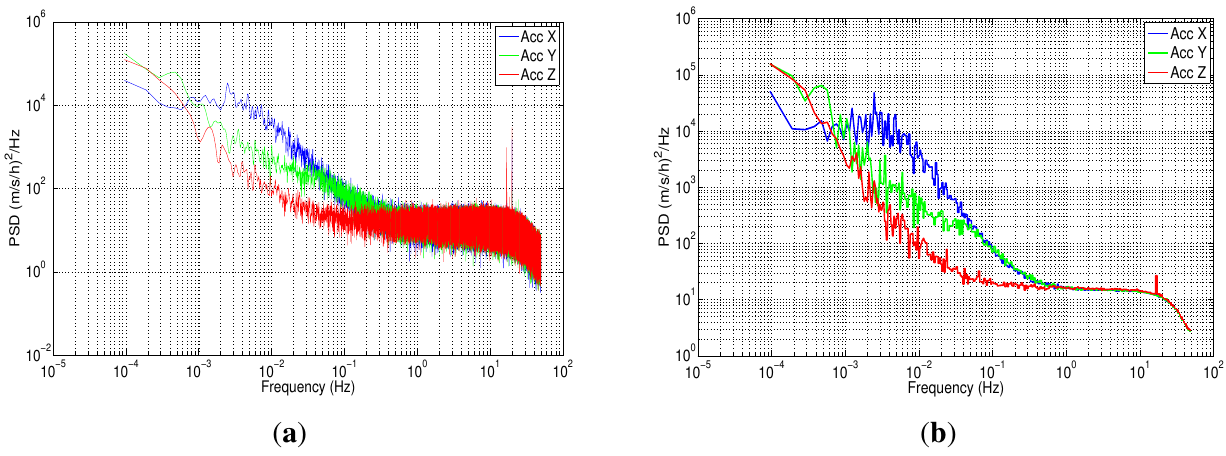
Figure 12. ( a ) Power spectral density accelerometer IMU 3DM-GX3-25; ( b ) power spectral density accelerometer IMU 3DM-GX3-25 after frequency